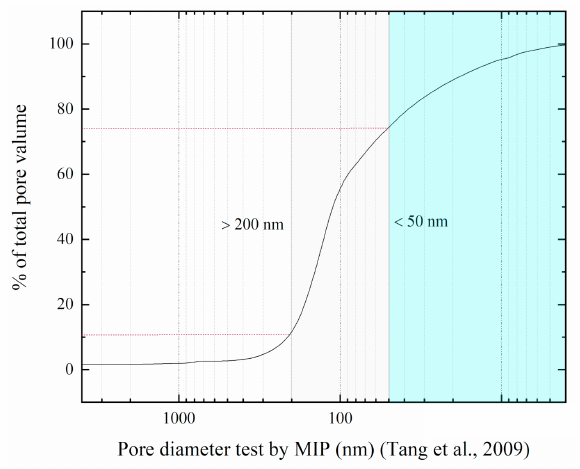
Figure 8. PSD test by mercury intrusion porosimetry